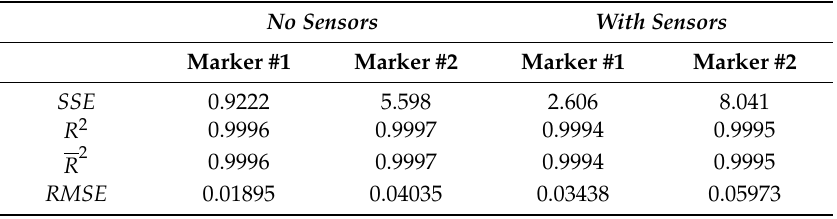
Table 7. Models fitted over three measurements: Goodness of the fitted